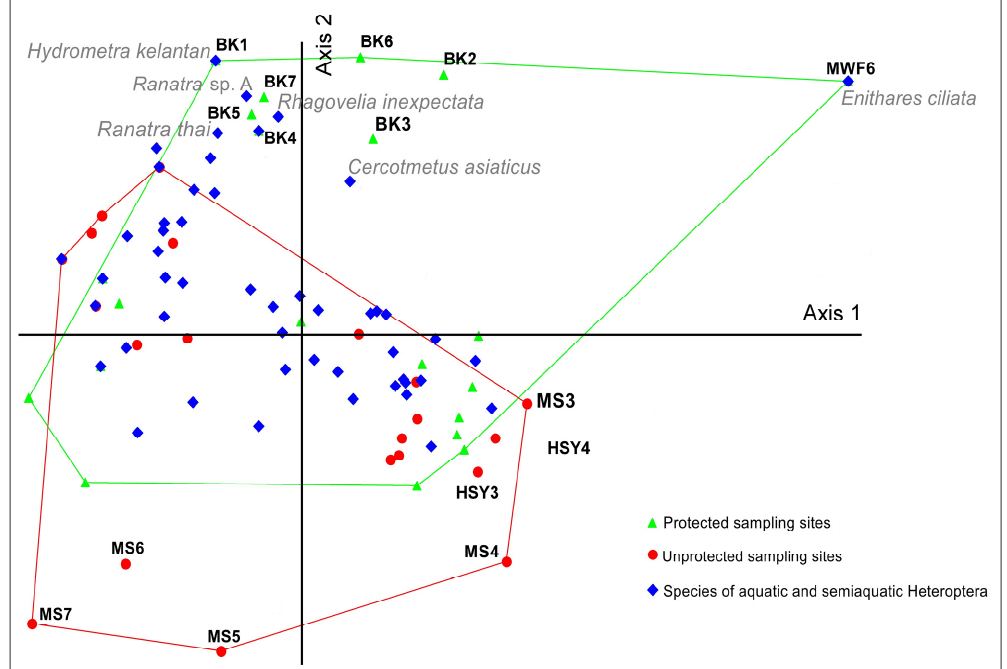
Figure 4. nMDS ordination plot samples by taxa dissimilarity (abundance data) between protected and unprotected sampling sites in the seven collecting events (stress = 14.80). Green refers to protected sampling sites, red refers to unprotected sampling sites, and blue refers to species.